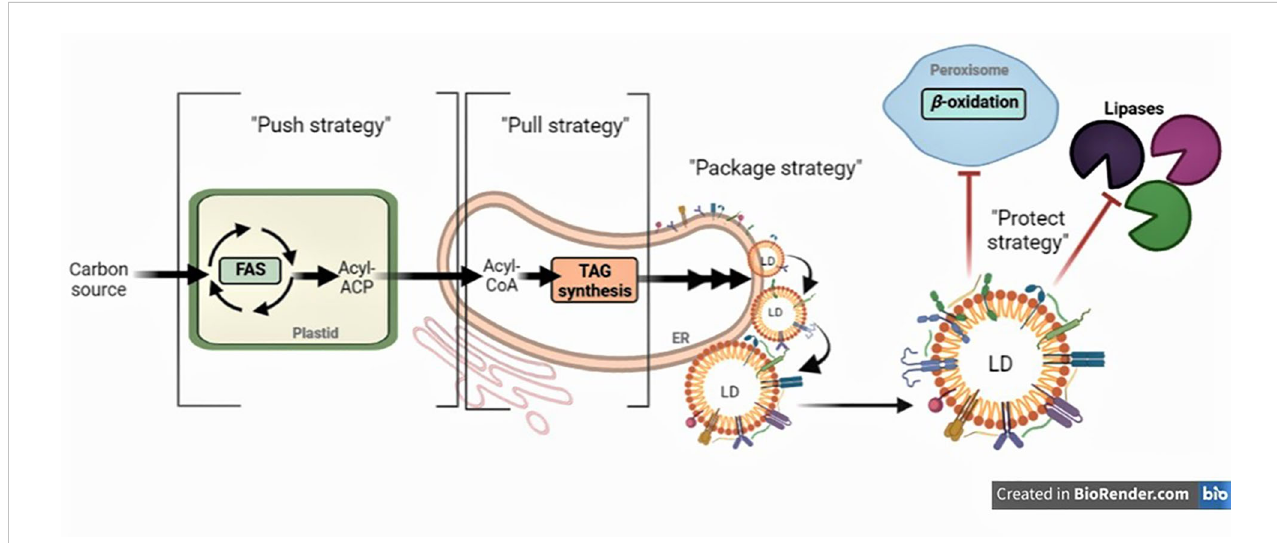
FIGURE 2 Improving oil quality in seeds by an integrated metabolic engineering approach. Broadly, strategies aim to (1) increase the carbon fl ux into de novo fatty acid synthesis (FAS) ( “ Push strategy ” ), (2) ensure ef fi cient assembly of nascent acyl chains into triacylglycerol (TG) ( “ Pull strategy ” ), (3) facilitate lipid droplet (LD) biogenesis and maximize droplet stability by proper coating ( “ Package strategy ” ), and (4) minimize TG turnover ( “ Protect strategy ”